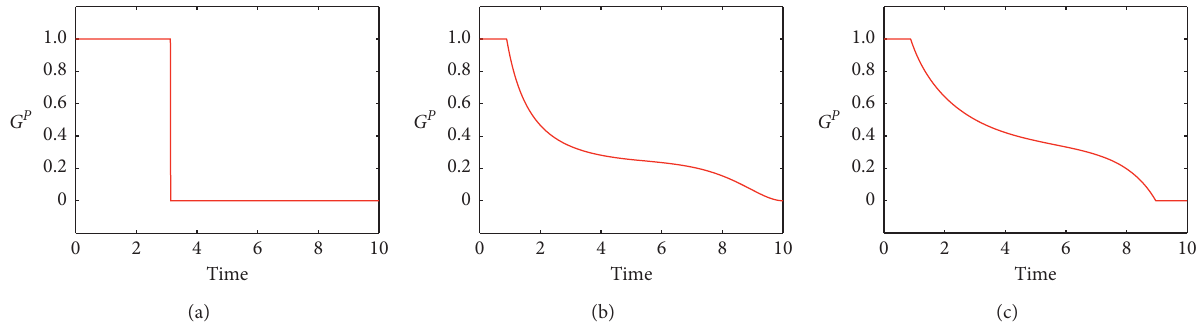
Figure 6: The promising rumor-containing scheme G p for three pairs of ( θ